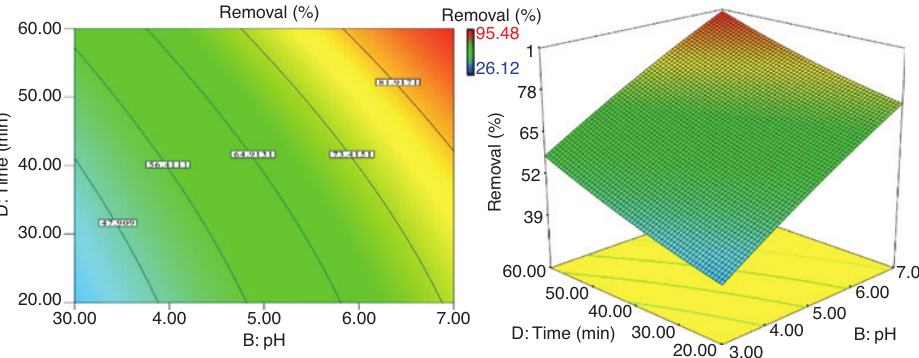
Figure 8: The contour and three-dimensional diagrams of Cd removal efficiency (%) as a function of pH and contact time.